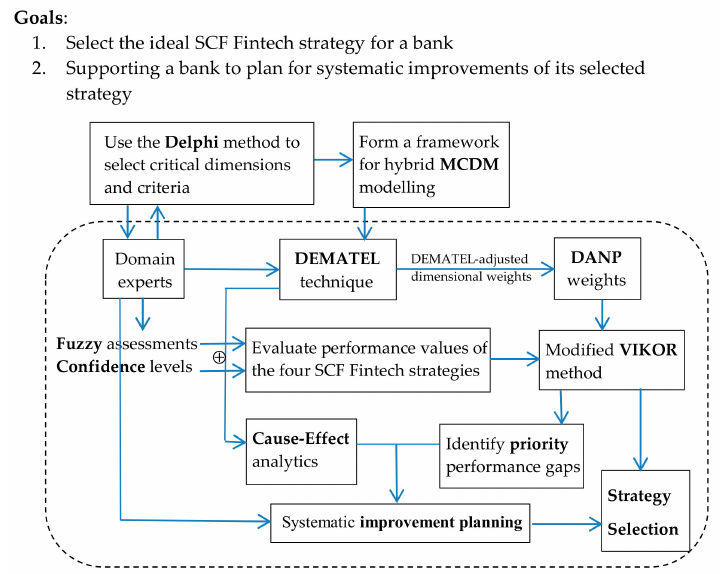
Figure 1. Conceptual flow of the research